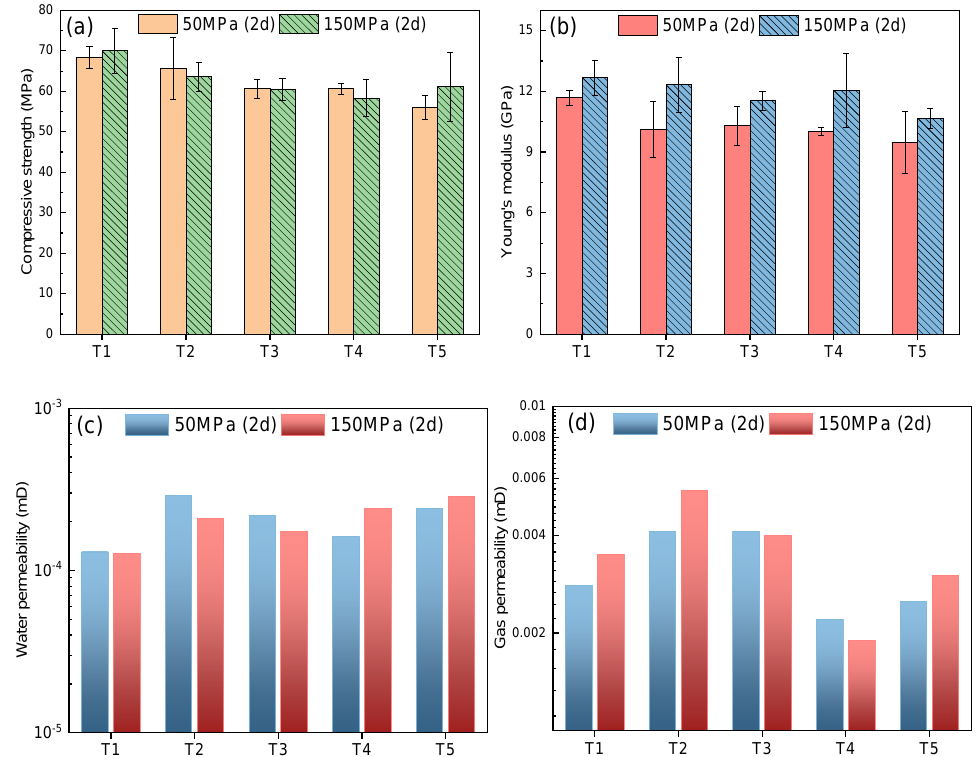
Figure 8. Mechanical properties and permeability of slurries T1 to T5 showed no significant influence of curing pressure on short-term test results: ( a ) compressive strength; ( b ) Young’s modulus; ( c ) water permeability; ( d ) gas permeability.